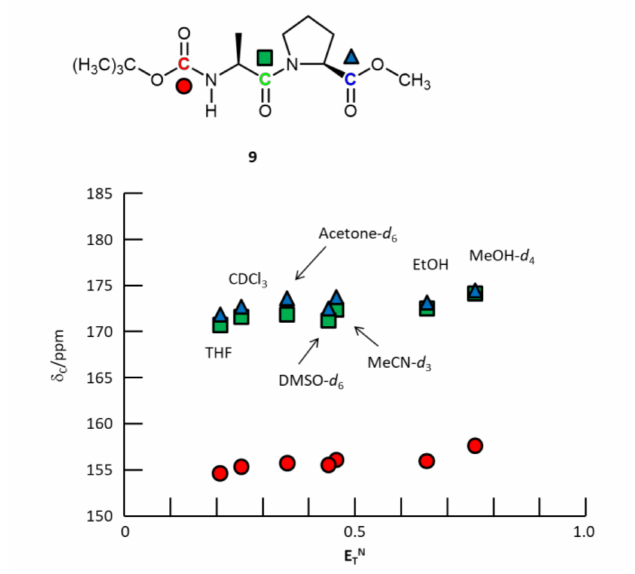
Figure 12. 13 C NMR chemical shifts of the carbonyl carbons of N -Boc-L-alanine-L-proline-OMe 9 . The dipeptide N -Boc-L-serine-L-proline-OMe 10 also showed downfield shifts for the two carbonyl carbons in the carbomethoxy group and in the peptide bond, while the change of the carbonyl carbon in the N -Boc group was slight except in EtOH and MeOH- d 4 (Figure 13). It is likely that only these protic solvents exhibited the influence because of the hydrogen bonding from these solvents. This pattern for the N -Boc group was similar to N -Boc-L-serine-OH 4a , N -Boc-L-serine-OMe 4b , and N -Boc-L-proline-L-serine-OMe 7 . These results suggest that the intramolecular hydrogen bonding can be formed between the carbonyl oxygen of the N -Boc group on the L-serine and the hydrogen atom of the hydroxy group of L-serine from the behavior of the carbonyl carbon of the N -Boc group in dipeptide 10 as will be described later (Scheme 5).